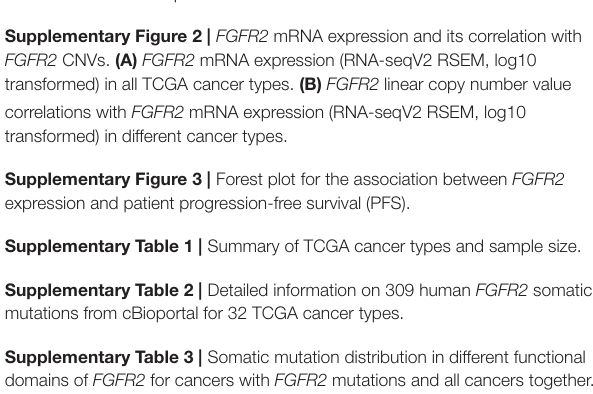
Supplementary Figure 1 | FGFR2 mutation distribution in different protein functional domains. (A) FGFR2 mutation distribution in different protein functional domains of FGFR2 across 32 TCGA cancer types together. (B) FGFR2 mutation distribution in different protein functional domains of FGFR2 in UCEC. Supplementary Figure 2 | FGFR2 mRNA expression and its correlation with FGFR2 CNVs. (A) FGFR2 mRNA expression (RNA-seqV2 RSEM, log10